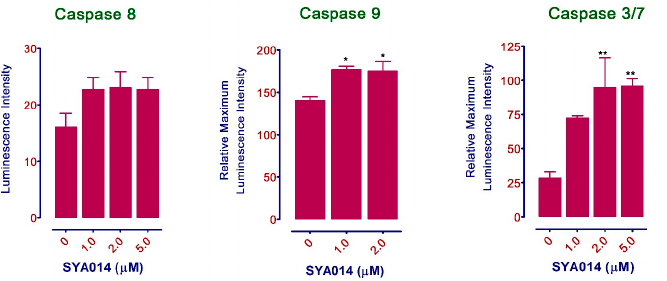
Figure 8. SYA014 induces apoptosis in MDA-MB-231 cells via activation of caspases 3/7 and 9. The activation of caspases 3, 7, and 9 was determined after treating MDA-MB-231 cells with SYA014 for 48 h using Caspase-Glo reagent according to the manufacturer’s protocol. * p < 0.05, and ** p < 0.01. Cancers 2022 , 14 , x FOR PEER REVIEW